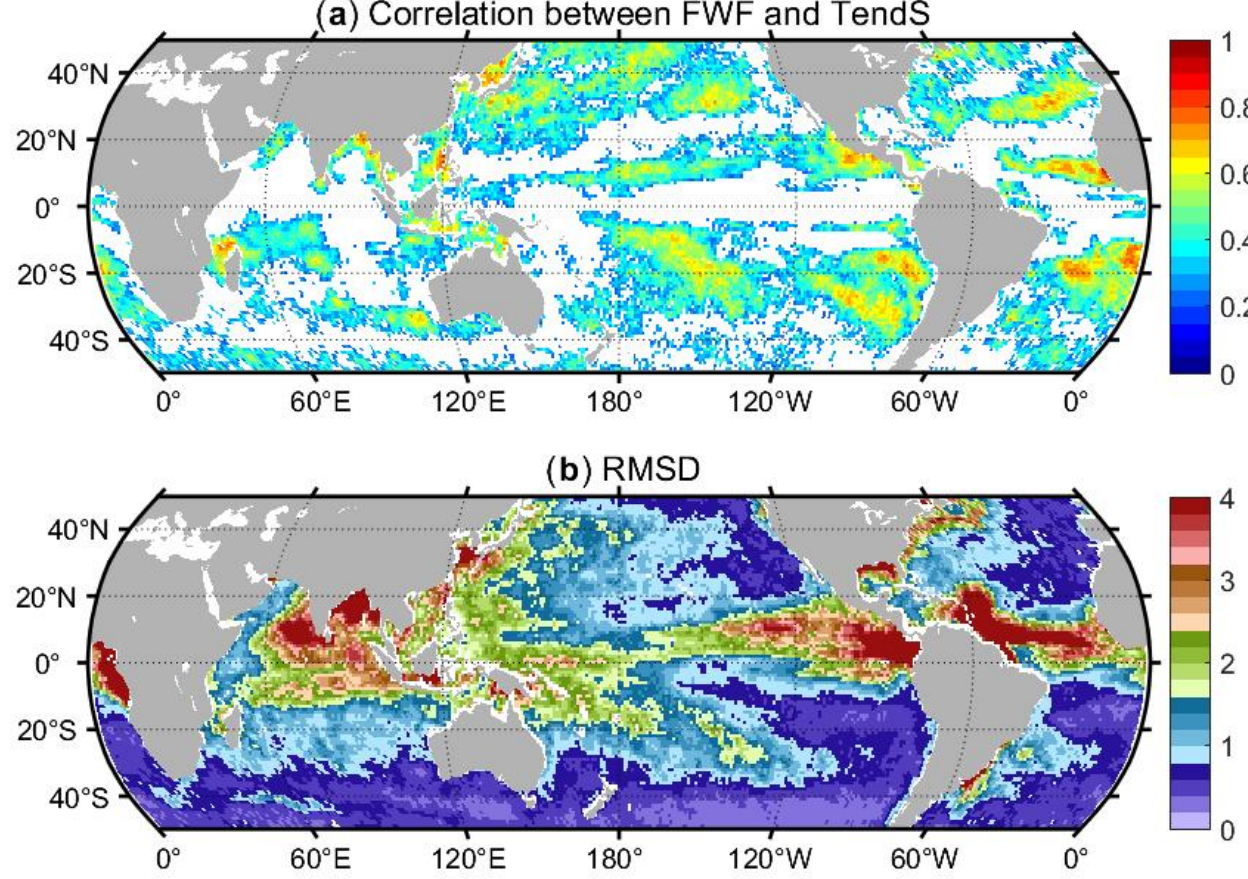
Figure 6. ( a ) The spatial distribution of correlation coefficients between ensemble median FWF and ensemble median SSS tendency calculated based on monthly values from 2012 to 2017. Margins denote sites with a p -value larger than 0.05 (insignificant) or a negative correlation between FWF and SSS tendency. ( b ) RMSD between the ensemble median FWF and ensemble median SSS tendency from 2012 to 2017. Correlation coefficients are unitless and units for RMSD are g/kg/year. The maximum RMSD (Figure 6b) between the FWF and SSS tendency mainly occurs over the rain belts or in the vicinity of major river outflow regions. Large uncertainty in SSS tendency or FWF also collocated within these regions, indicating that differences in FWF and SSS tendency can be partially attributed to spread among SSS or FWF products.